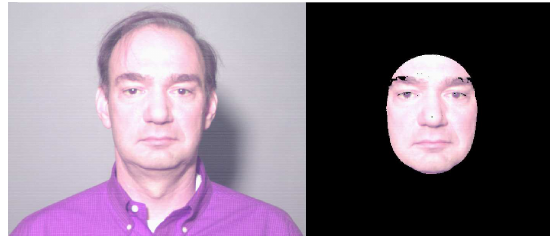
Fig. 7. Left figure is the original face; right side is the cropped face using a sphere r = 100 mm; the center of the sphere is at the nose tip.